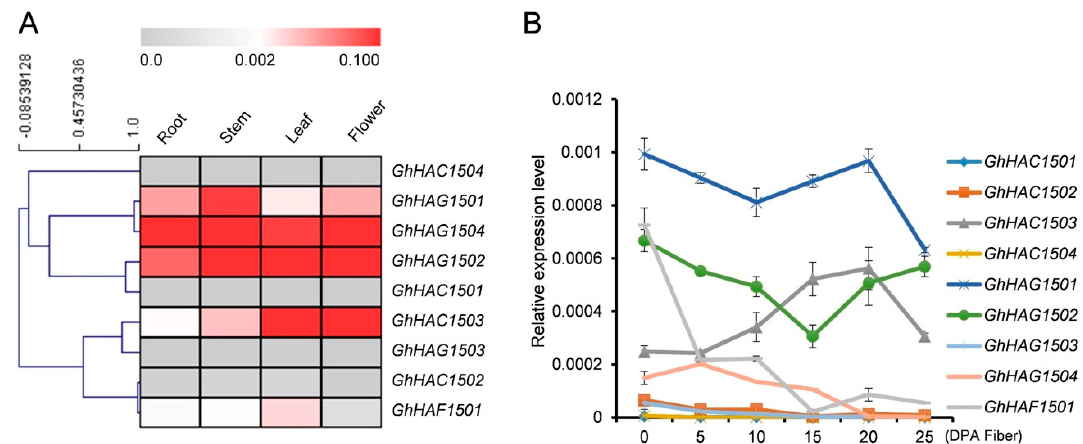
Figure 5. Gene expression validation of HATs from G. hirsutum by quantitative real-time polymerase chain reaction (qRT-PCR) in different tissues. ( A ) RNA from the root, leaf, stem and flowers was extracted and reverse transcribed. Ubiquitin 7 ( UBQ7 ) was used as an internal control for qRT-PCR. The relative expression is presented in the heat map, and the color scale at the top represents the relative signal intensity. The primer sequences can be found in Table S5. ( B ) Gene expression validation of HATs from G. hirsutum by qRT-PCR at different stages of fiber development. The data were normalized to UBQ7 . The data presented are the average of three biological replicates. Bar = standard deviation (SD).